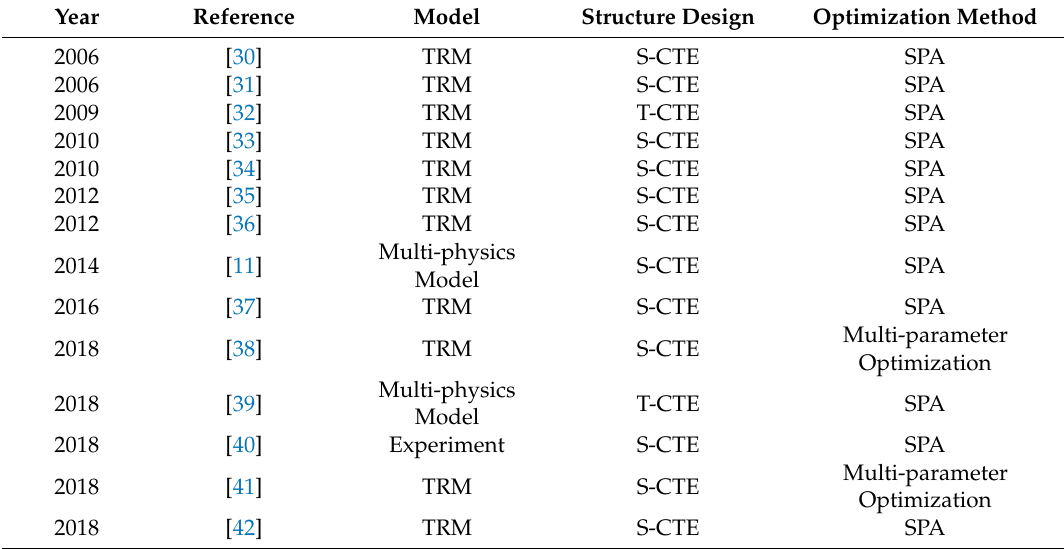
Table 1. Summary of previous literature